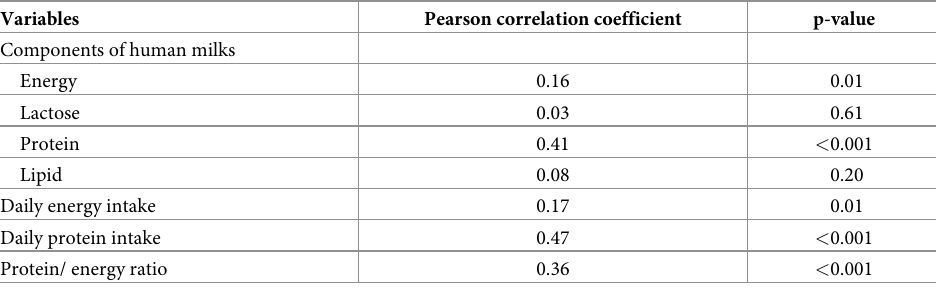
Table 3. Correlation with the velocity of body weight gain (g/kg/day).